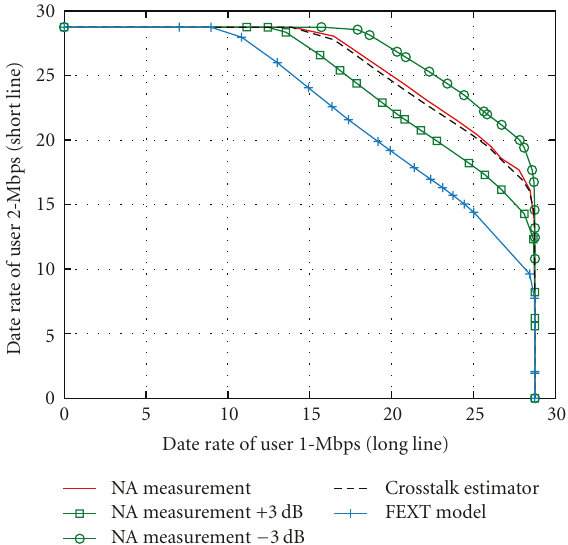
Figure 11: Section of the 10-dimensional rate region curve, obtained with SCALE, for 2 users (out of 10 users) with nonequal length